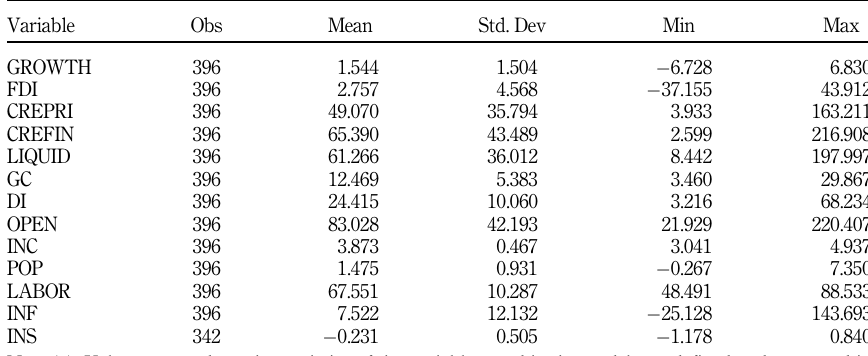
Table A1. Variable measurement and data